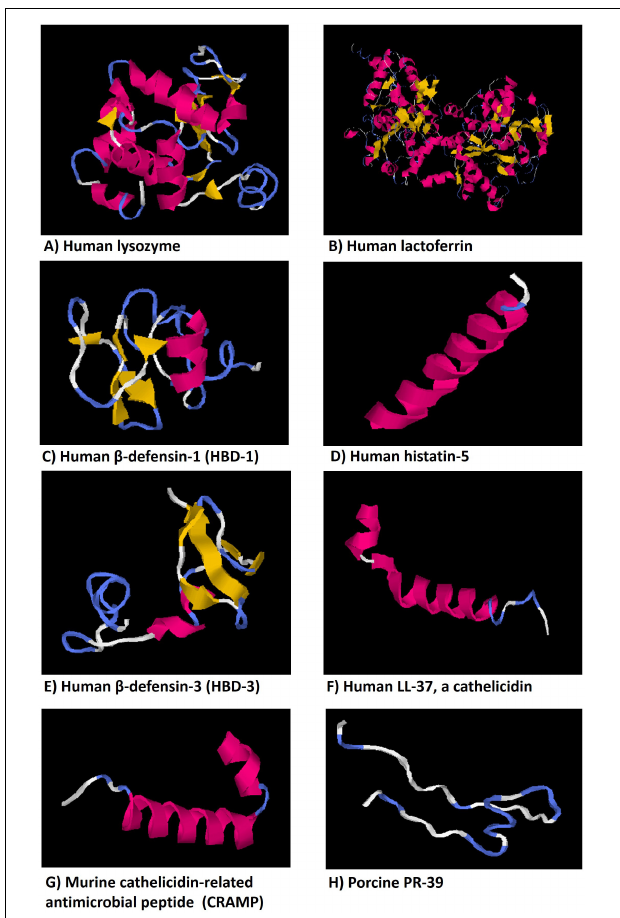
FIGURE 3 | Representative models of some antifungical peptides showing alpha-helical, beta-sheet, amphiphilic structural motifs that relate forms and functions. The three-dimensional structure models of peptides were predicted using the on-line server Iterative Threading ASSEmbly Refinement (I-TASSER, Yang Zhang Lab), University of Michigan (Ann Arbor, MI, United States), from their amino acid